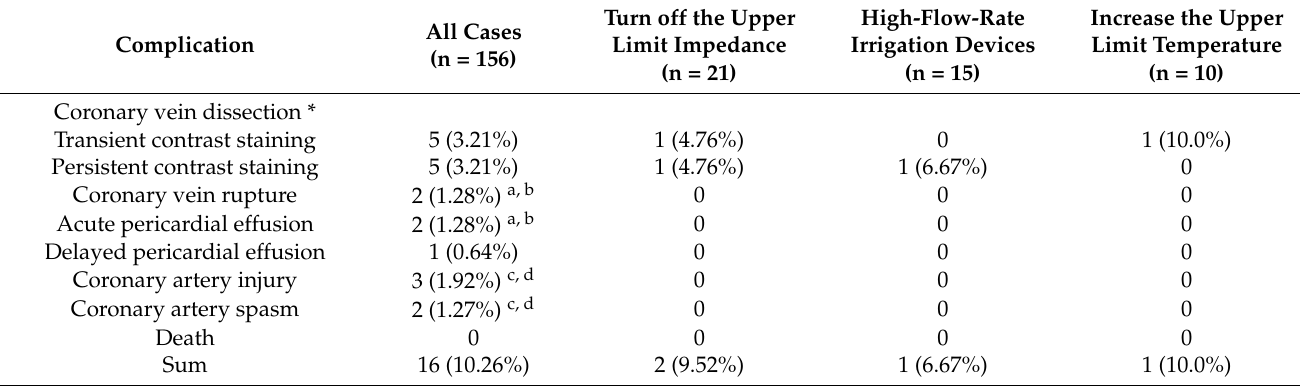
Table 3. The complications of radiofrequency catheter ablation in